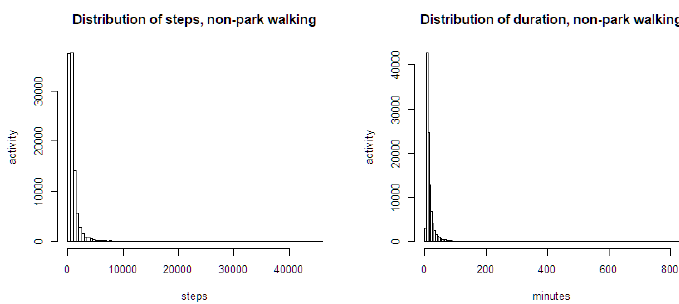
Figure 3. Distribution of steps and duration of walking bouts. Table 3. Mann–Whitney u tests for two independent sample groups.